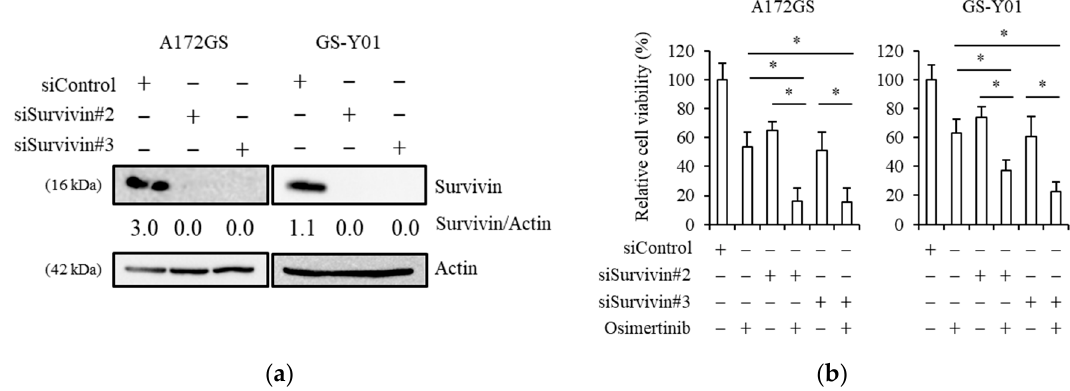
Figure 3. siRNA-mediated knockdown of survivin sensitizes GSCs to osimertinib: The indicated GSCs were transfected with a non-targeting siRNA (siControl) or either of the siRNAs against survivin (siSurvivin#2 or siSurvivin#3) for 3 days. ( a ) The cells were subjected to immunoblot analysis for survivin protein expression. ( b ) Then, the transfected cells were treated with or without 1.5 μ M of osimertinib for 3 days, and the cells were subjected to cell viability assay using WST-8. Values represent means + SD from quadruplicate samples of a representative experiment repeated with similar results. * p < 0.05.